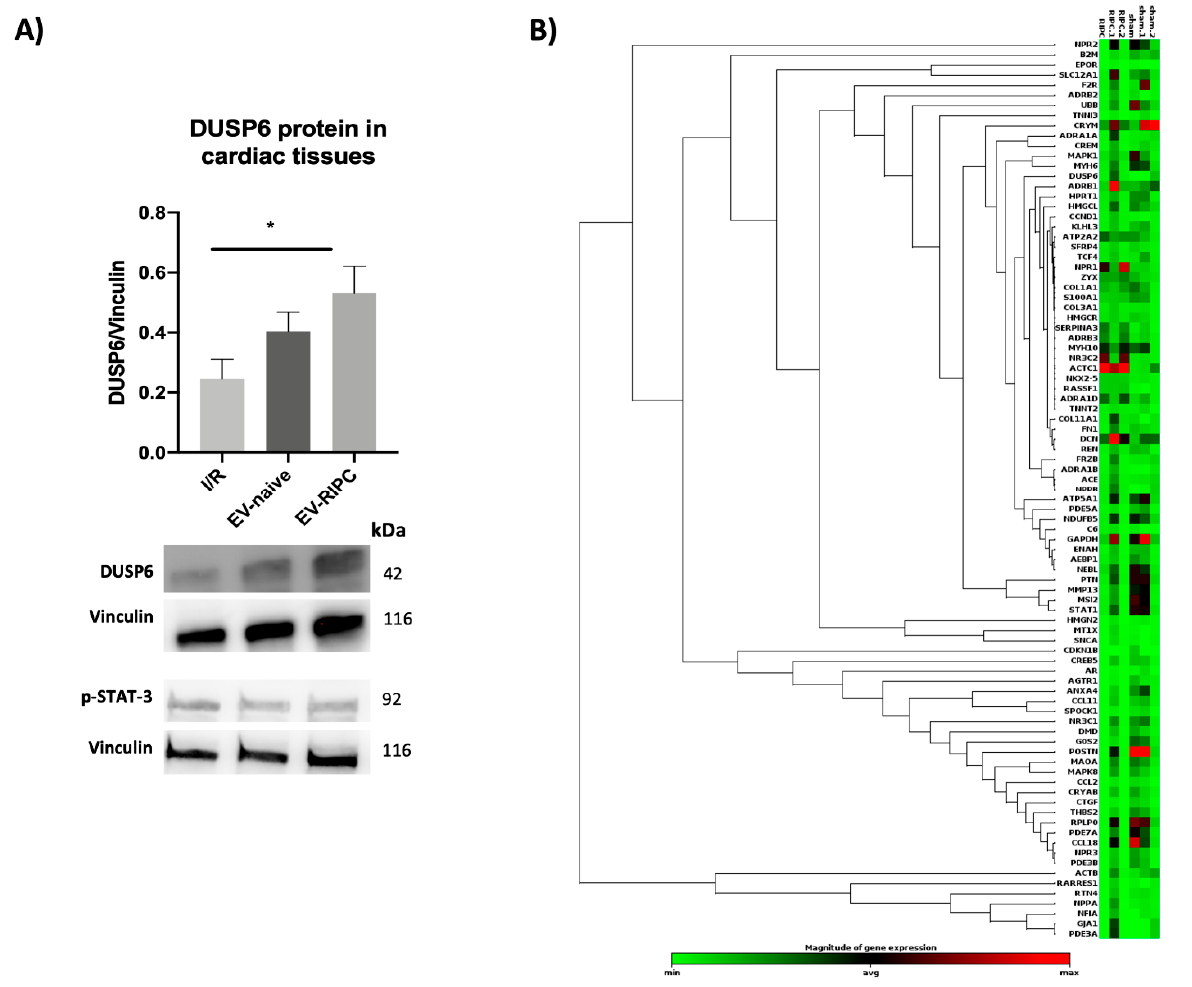
Figure 5. DUSP6 content in cardiac tissue and EV heatmap. ( A ) Representative images of Western blot for DUSP6 and p-STAT-3. The histogram refers to DUSP6 expression in myocardial tissue. DUSP6 and p-STAT-3 expression were normalized to vinculin (n = 30) (* p = 0.02). ( B ) Hierarchical clustering of the entire dataset of expressed cardiovascular-linked genes. Clustergram displaying hierarchical clustering of the entire dataset of expressed genes across two different experimental groups: EV-RIPC and EV-naive (n = 3/each group). RNAs with higher differential expression levels are represented in red, while RNAs with lower detection levels are shown in green. Genes with similar expression patterns are grouped.